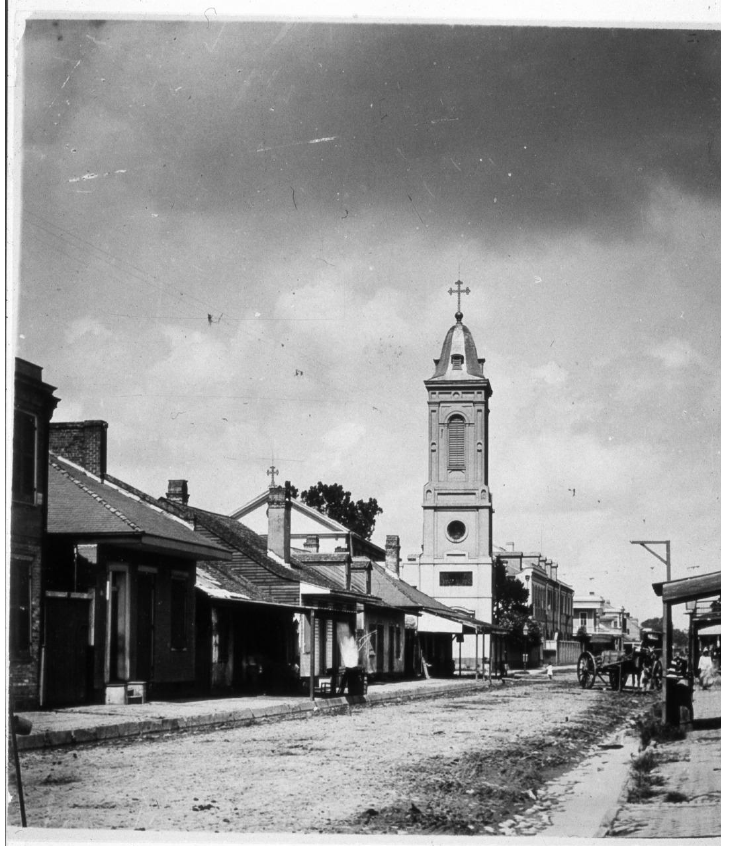
Figure 7. Saint Augustine Catholic Church circa 1900s; image courtesy of the Historic New Orleans Collection.